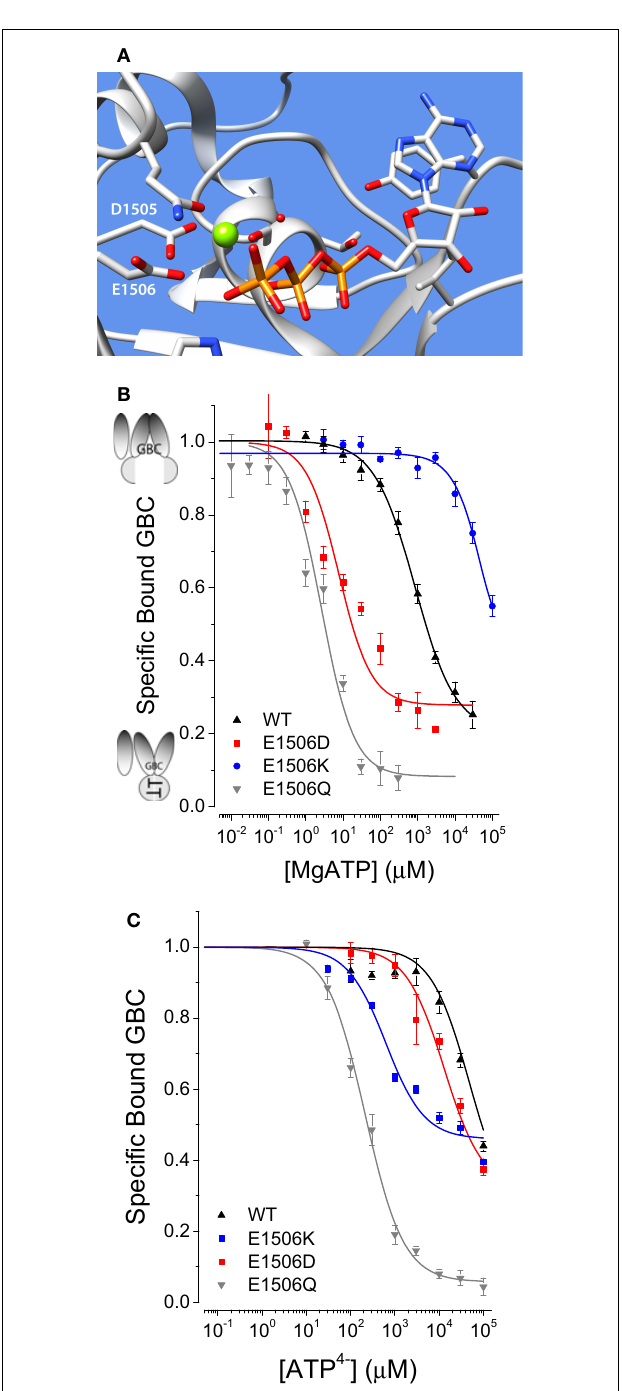
FIGURE 2 | (A) Representation of NBD2 based on Sav1866. Comparison of MgATP-induced conformational switching by MgATP (B) or ATP 4 − (C) . Here and in subsequent figures ND mutation data are in red, CHI mutation data are in blue, and wildtype (WT) data are in black.